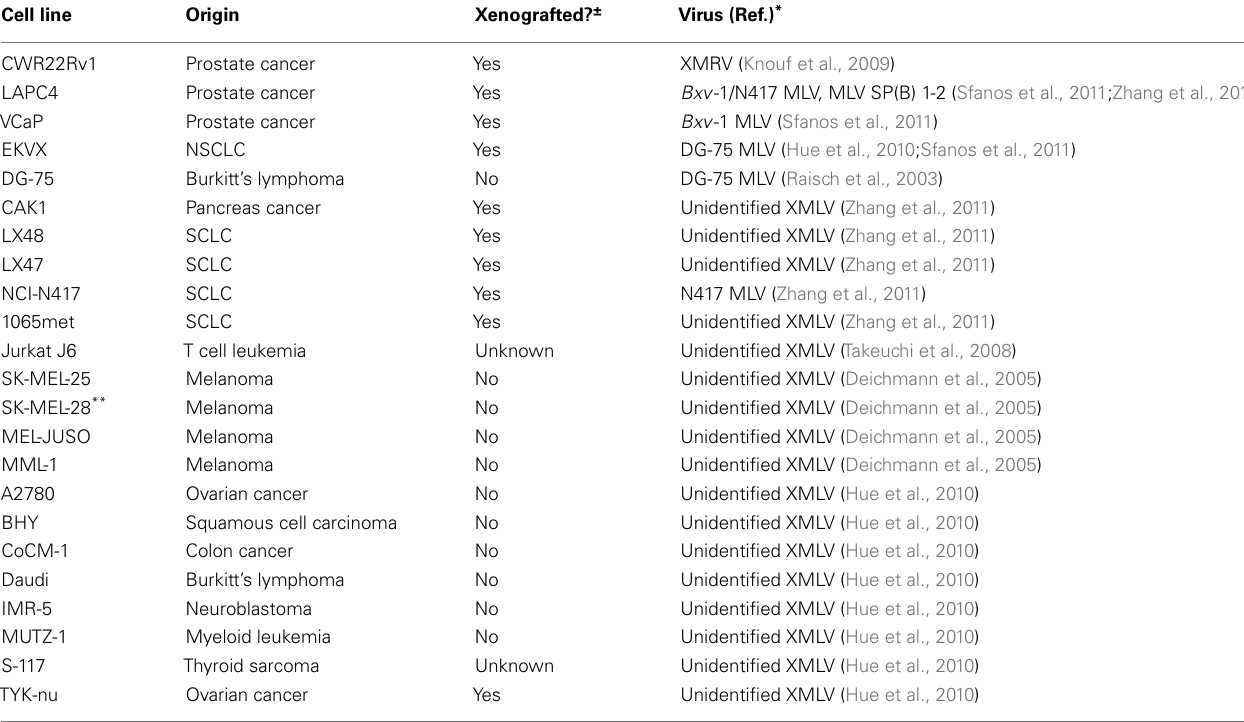
Table 1 | Reports of XMLV infection of cancer cell